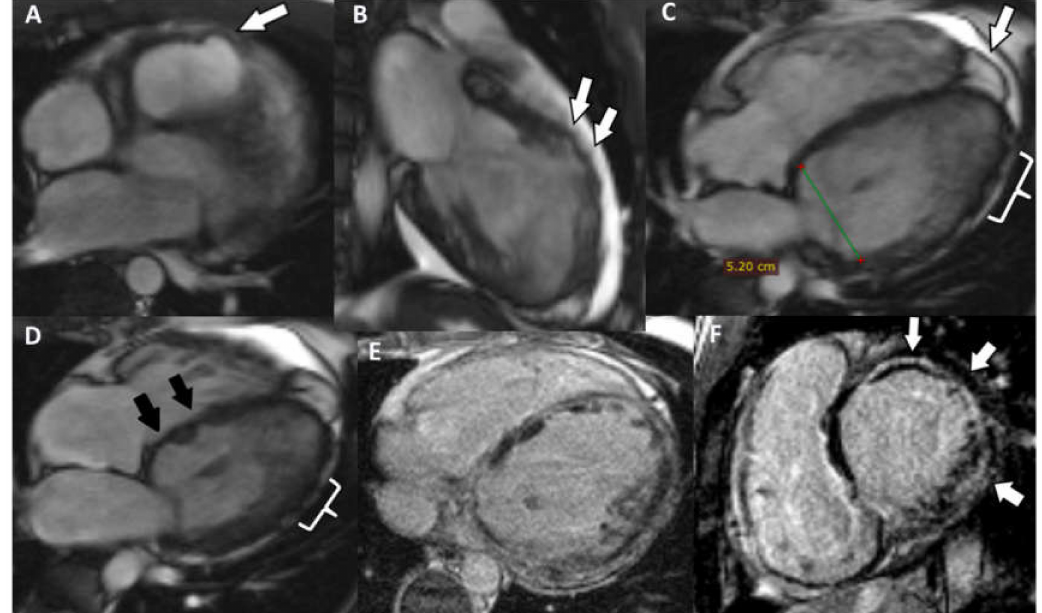
Figure 4. ( A ) Axial Cine-GRE sequence: focal dyskinesia of the RVOT; ( B ) Cine-GRE two-chamber LV sequence: focal dyskinesia of the anterior wall of the LV; ( C , D ) four-chamber Cine-GRE sequence: focal dyskinesia of the RV apex (arrow), dyskinesia of the lateral wall of the LV (square brackets), akinetic IVS areas (black arrows); ( E ) PSIR sequence—delayed postcontrast axial view: concentric midmyocardial LGE within the LV and diffuse, inhomogeneous LGE of the lateral wall of RV; ( F ) PSIR sequence—delayed postcontrast short axis view: midmyocardial LGE of the LV